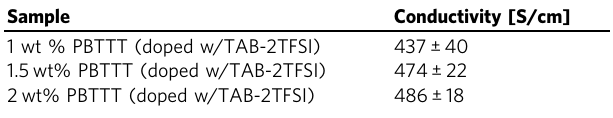
Table 1 Average conductivity values measured using the 4-point probe method for fi lms made from 1, 1.5, and 2 wt% PBTTT doped with TAB-2TFSI, measured at 10 different spots in a fi